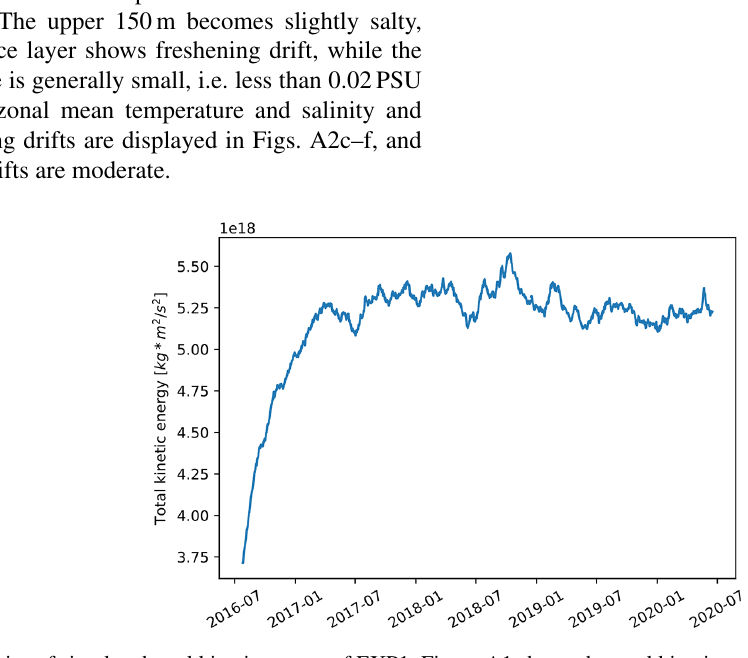
Figure A1. Time series of simulated total kinetic energy of EXP1. Figure A1 shows the total kinetic energy of EXP1 since the beginning of the numerical experiment. The 1 / 32 ◦ model starts from a 1 / 10 ◦ model state and enters a new steady state after a swift adjustment period of about 1 year. After the short spin-up period, the total kinetic energy reaches quasi-steady state with small